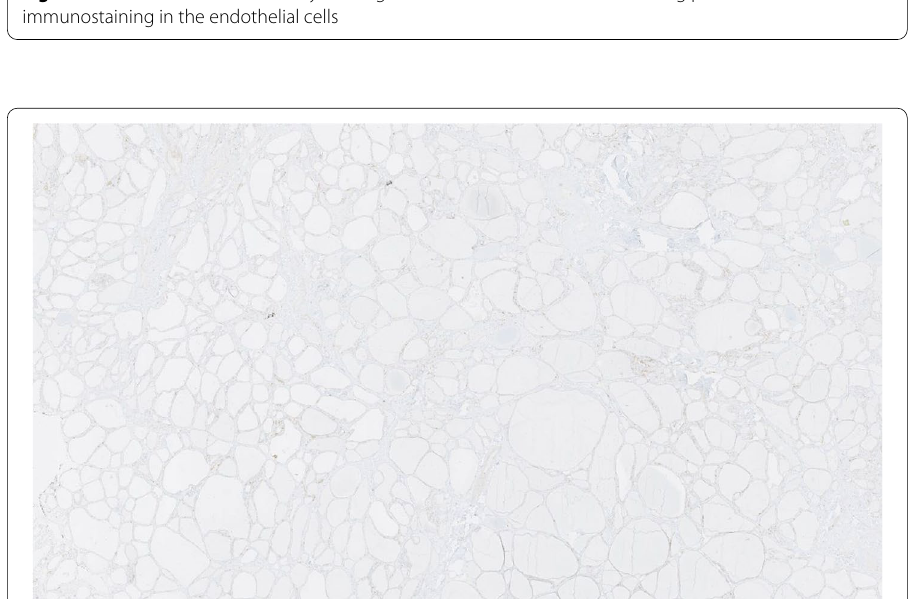
Fig. 4 SSTR2 IHC staining of healthy surrounding thyroid